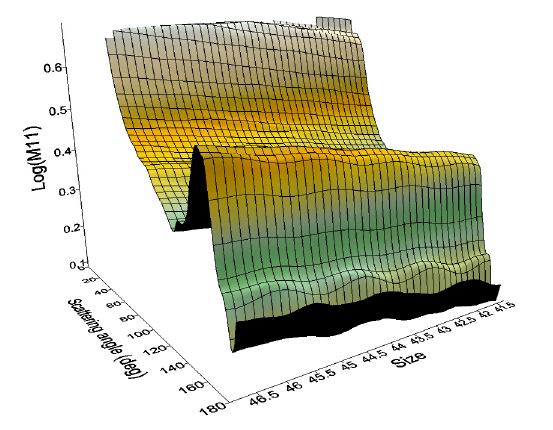
Figure 5. The interference oscillation of the first element of the Mueller matrix in the backscattering